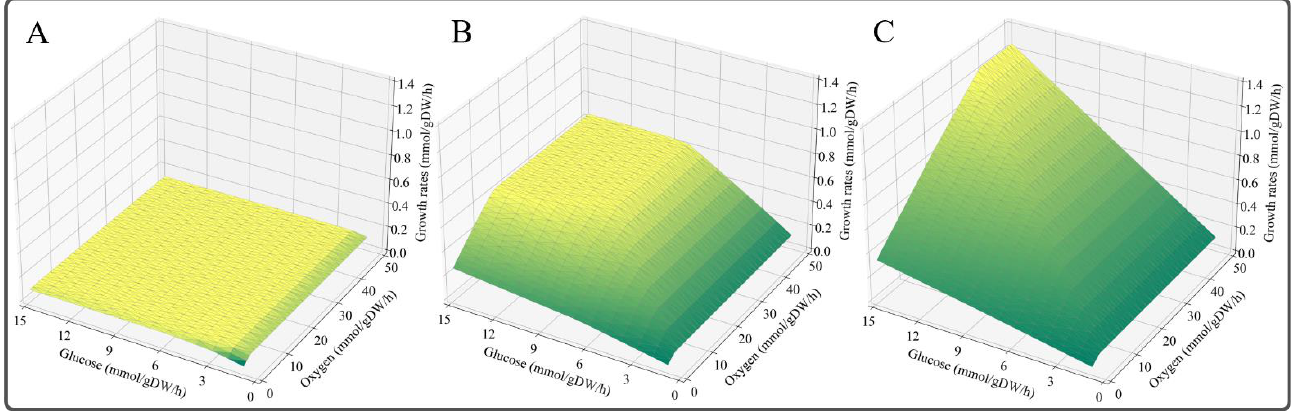
Figure 3. The solution space of iBsu1147 R and ecBSU1. Changes in the maximal growth rate with the increase of glucose and oxygen uptake rates in ecBSU1 before k cat correction ( A ), ecBSU1 after k cat correction ( B ), and iBsu1147 R ( C ).